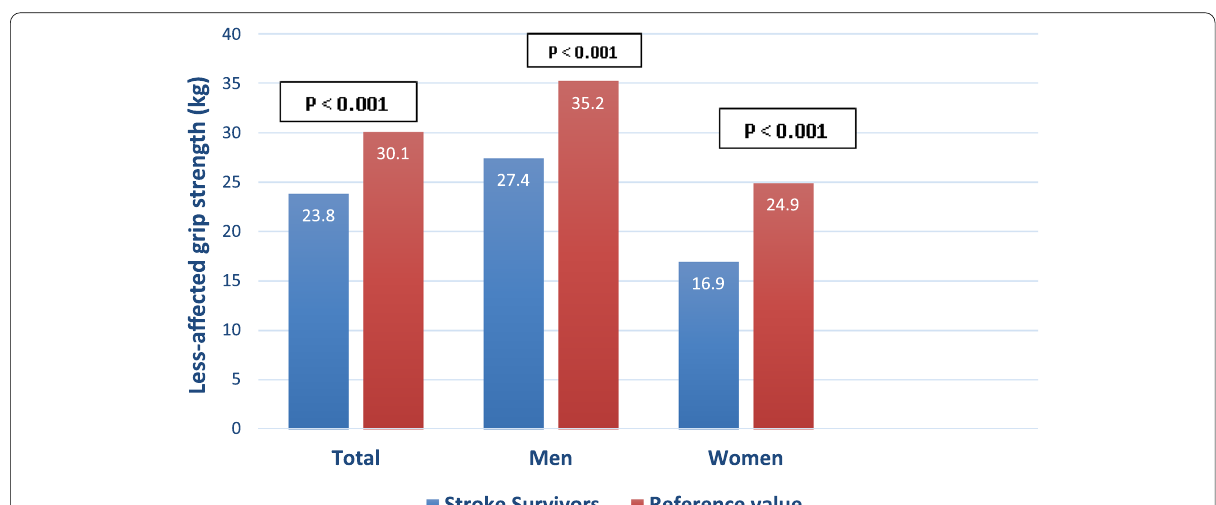
Fig. 1 Bar chart showing less-affected grip strength of stroke survivors compared to the reference of healthy adults. Data are shown in mean and standard